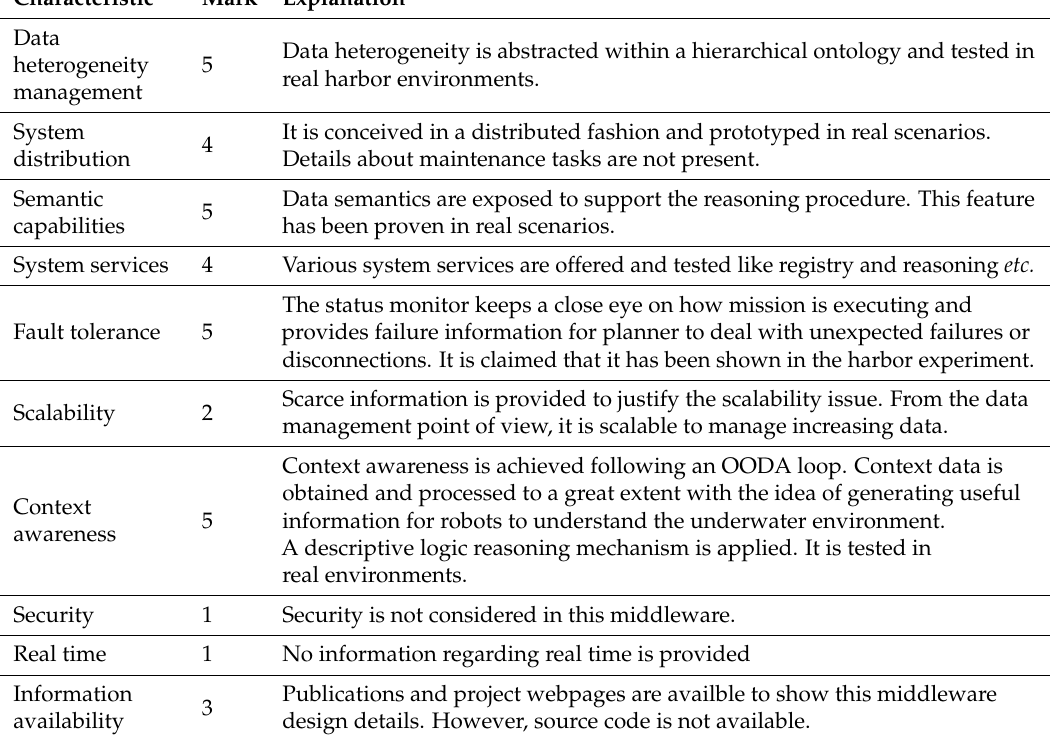
Table 16. Trident